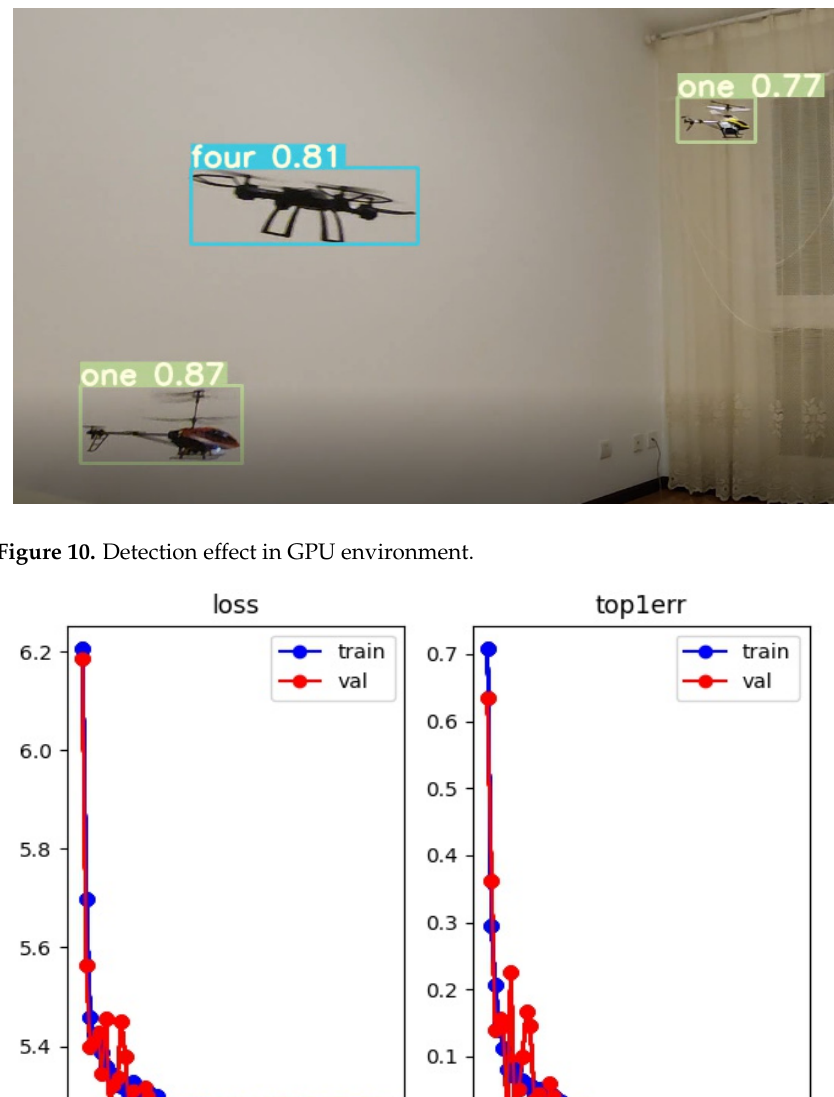
Figure 10. Detection effect in GPU environment.